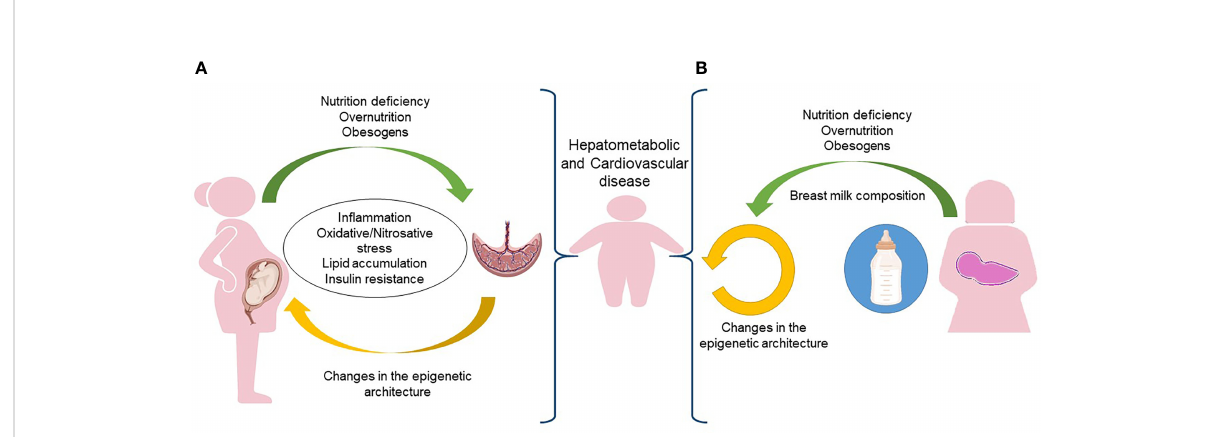
FIGURE 2 In utero and postnatal predisposition to obesity. (A) During pregnancy, the placenta of a woman exposed to nutrition de fi ciency, overnutrition or obesogens, is subjected to in fl ammation, oxidative/nitrosative stress, lipid accumulation and insulin resistance that increases the risk of obesity and its comorbidities in the newborn. (B) The same risk of obesity and comorbidities early in the life could be associated to epigenetic changes occurring in the breast milk. Figure partially created with